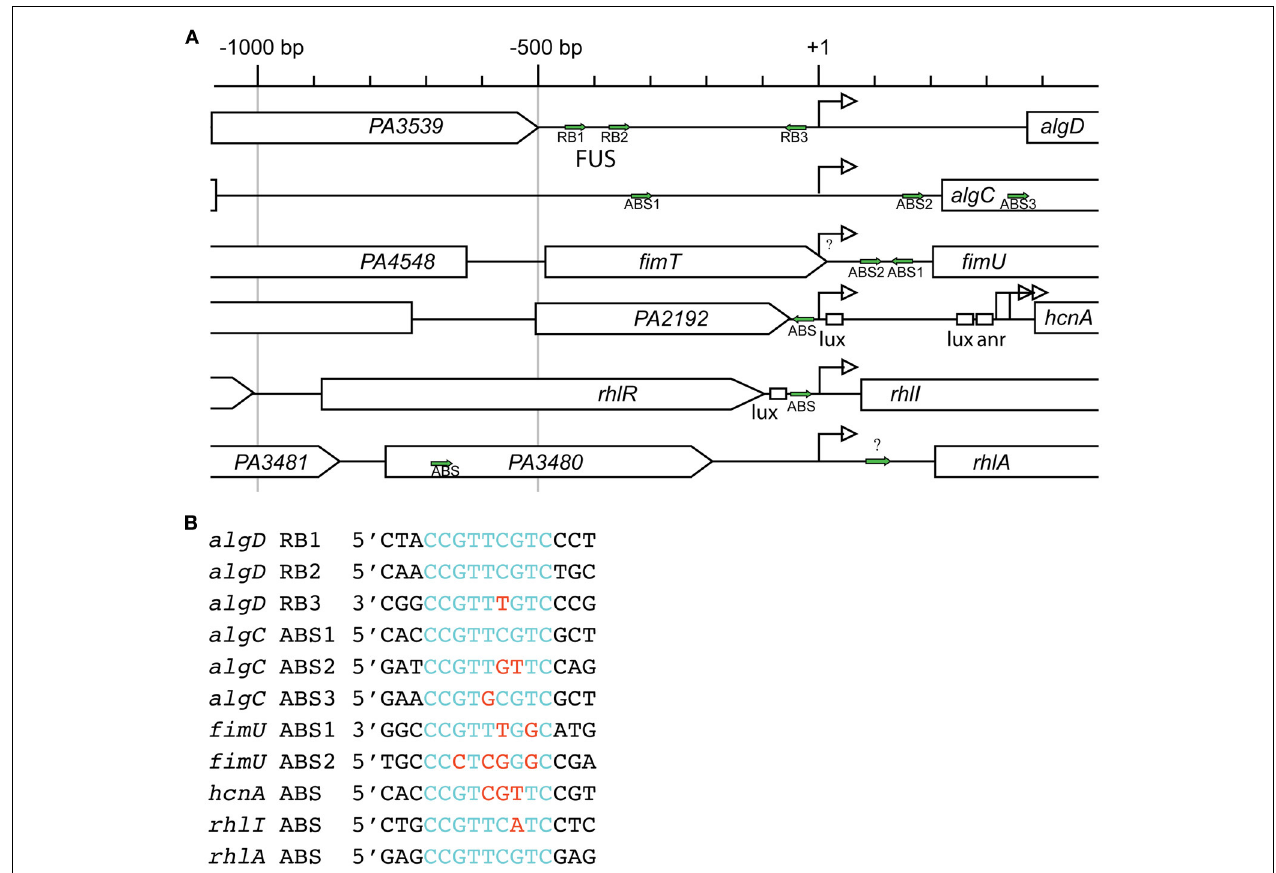
FIGURE 3 | AlgR regulated promoter complexity. (A) Comparison of AlgR binding site locations within its regulated gene promoters. Gene names are labeled within arrowed boxes, and pointed end of boxes indicate open coding direction. Promoters are aligned to the gene’s transcriptional start sites ( + 1). Identified AlgR-binding sites (ABS) are indicated by green arrows. Lux, LasR